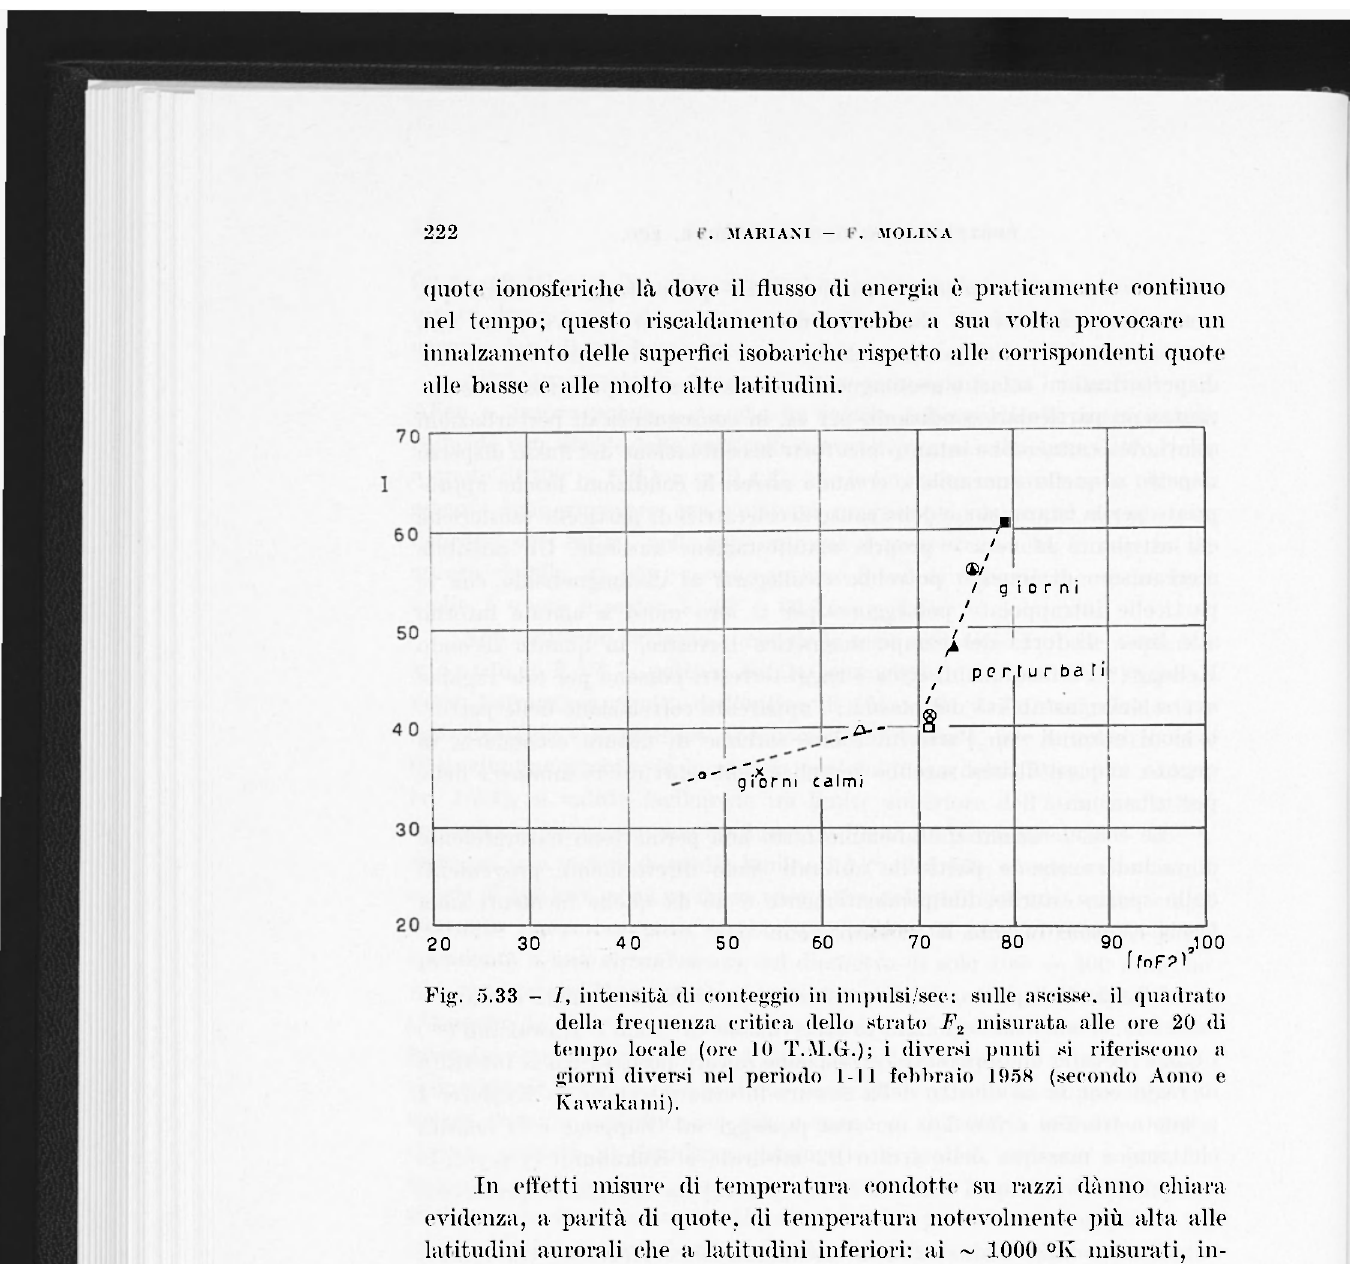
Fig. 5.33 - 7, intensità di conteggio in impulsi/sec; sulle ascisse, il quadrato della frequenza critica dello strato F 2 misurata alle ore 20 di tempo locale (ore 10 T.M.G.); i diversi punti si riferiscono a giorni diversi nel periodo 1-11 febbraio 1958 (secondo Aono e